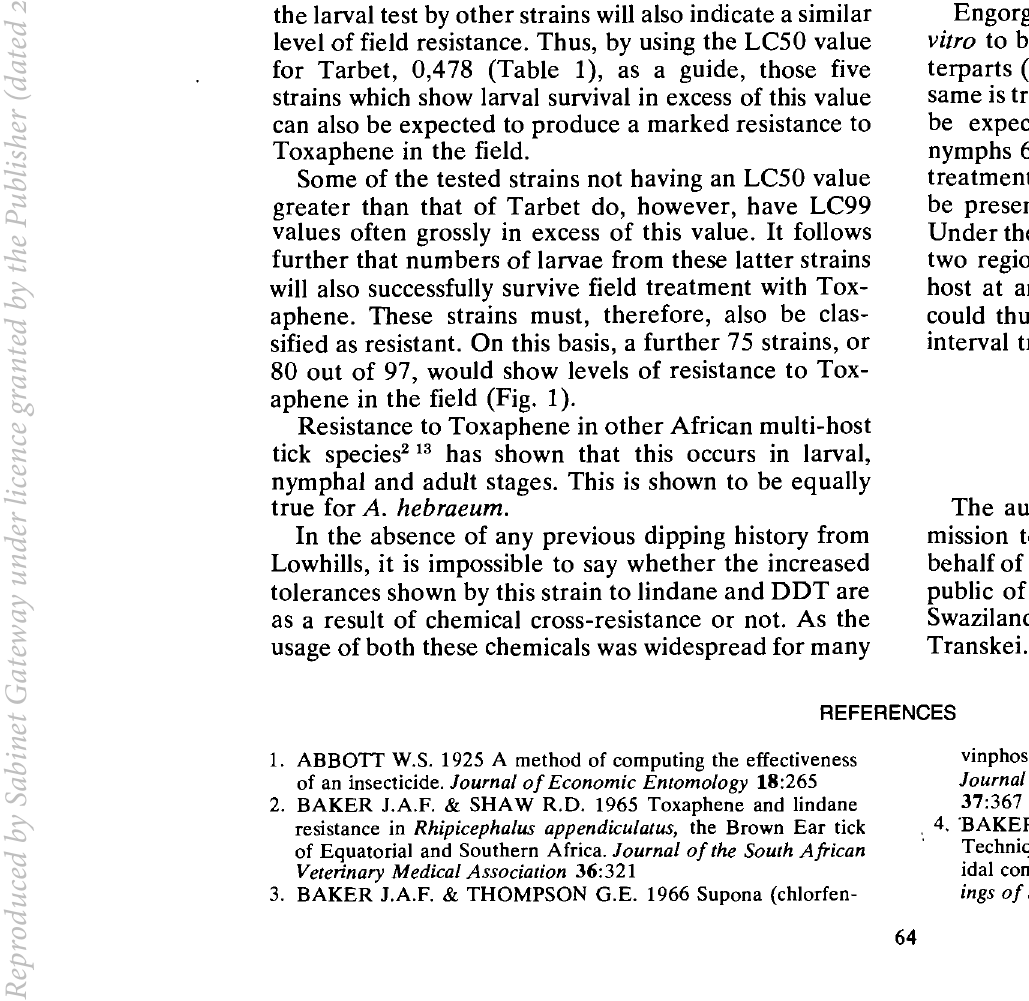
Fig. 3 A comparison of the counts of A. hebraeum adult ticks on groups of cattle at 'Tarbet' and 'Gulu' before and 2 days after treatment. A: Untreated Controls; B: 0,25% Toxaphene hand spraywash; C: 0,25% Toxaphene plunge dipwash.